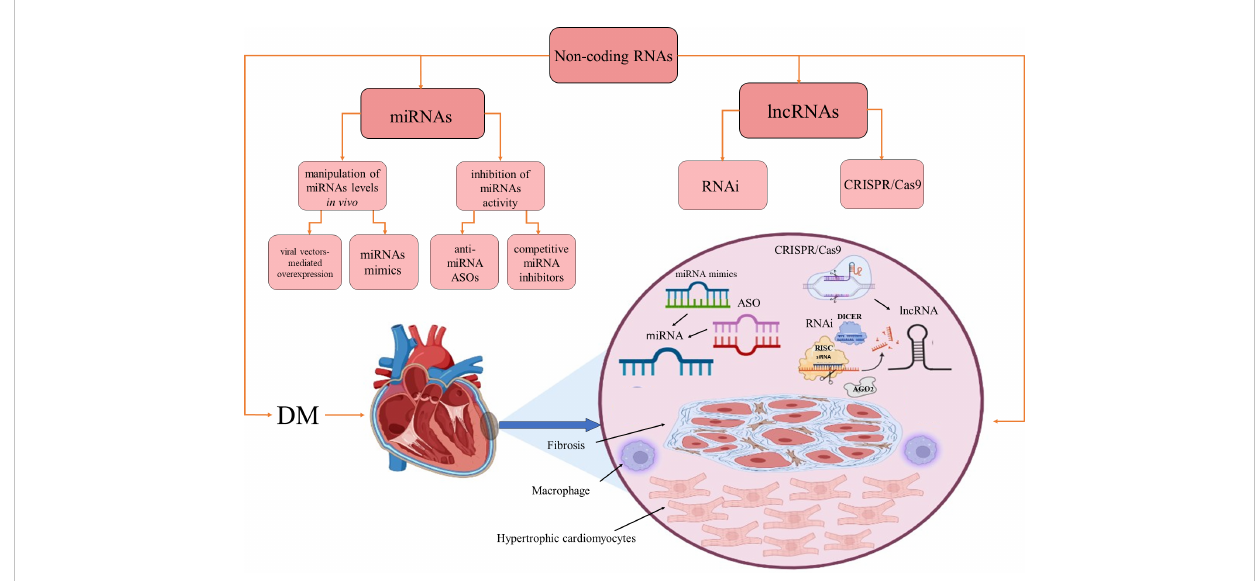
FIGURE 2 Therapeutic approaches based on miRNAs and lncRNAs. Non-coding RNAs as therapeutics in diabetes-induced cardiomyopathy. AGO2, Argonaute RISC Catalytic Component 2; ASO, antisense oligonucleotide; DM, diabetes mellitus; RISC, RNA-induced silencing complex; RNAi, RNA interference. Created with